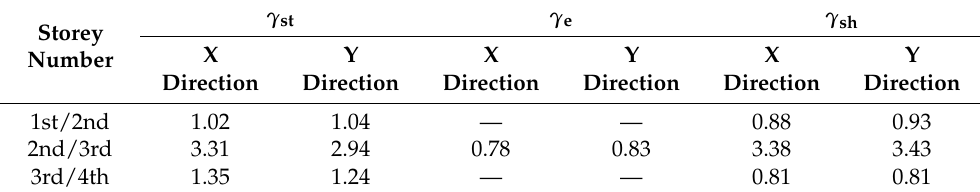
Table 7. Calculation values of the parameters γ st , γ e and γ sh .